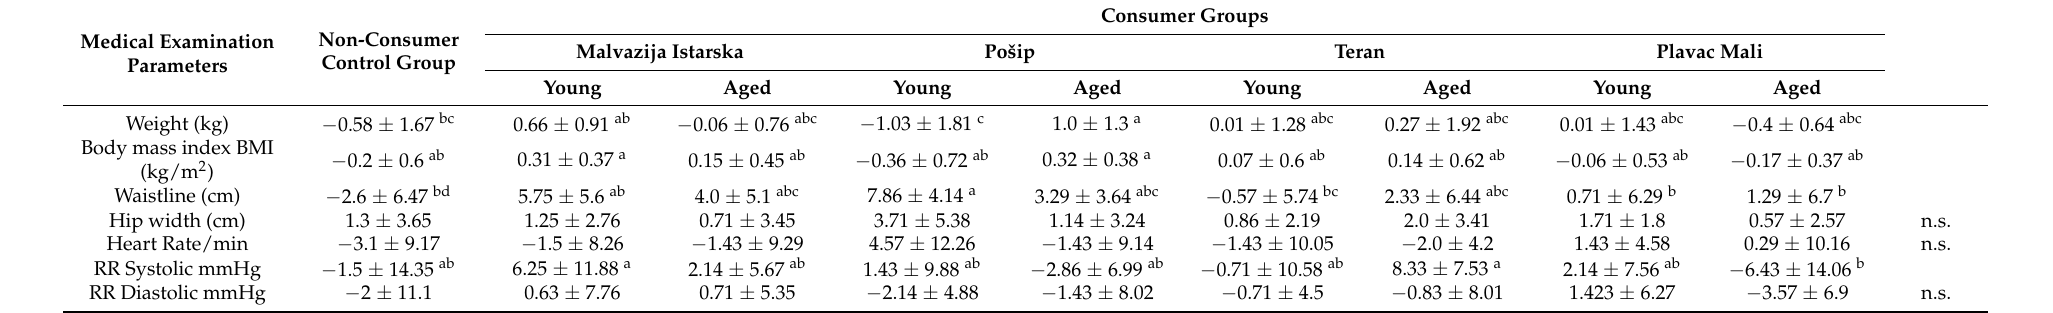
Table 9. Changes in different medical examination parameters after the consumption period in eight consumer groups and one non-consumer group of study participants.